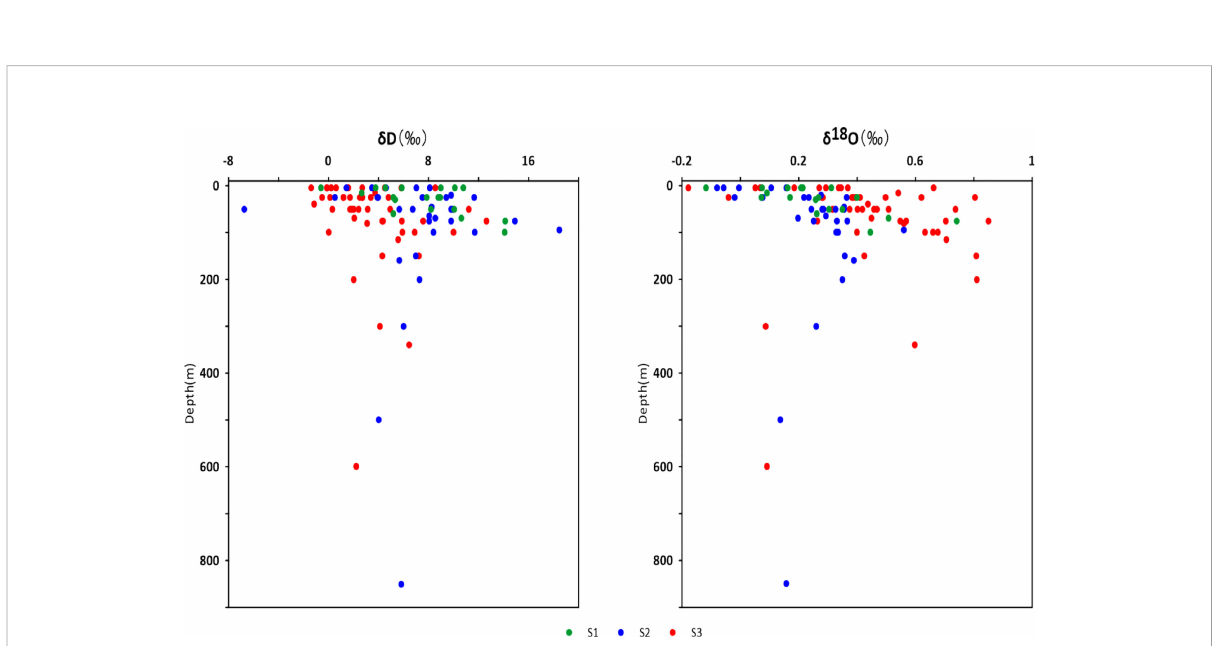
FIGURE 4 Vertical pro fi les of d 18 O and d D in the three sections of the PRE and the adjacent